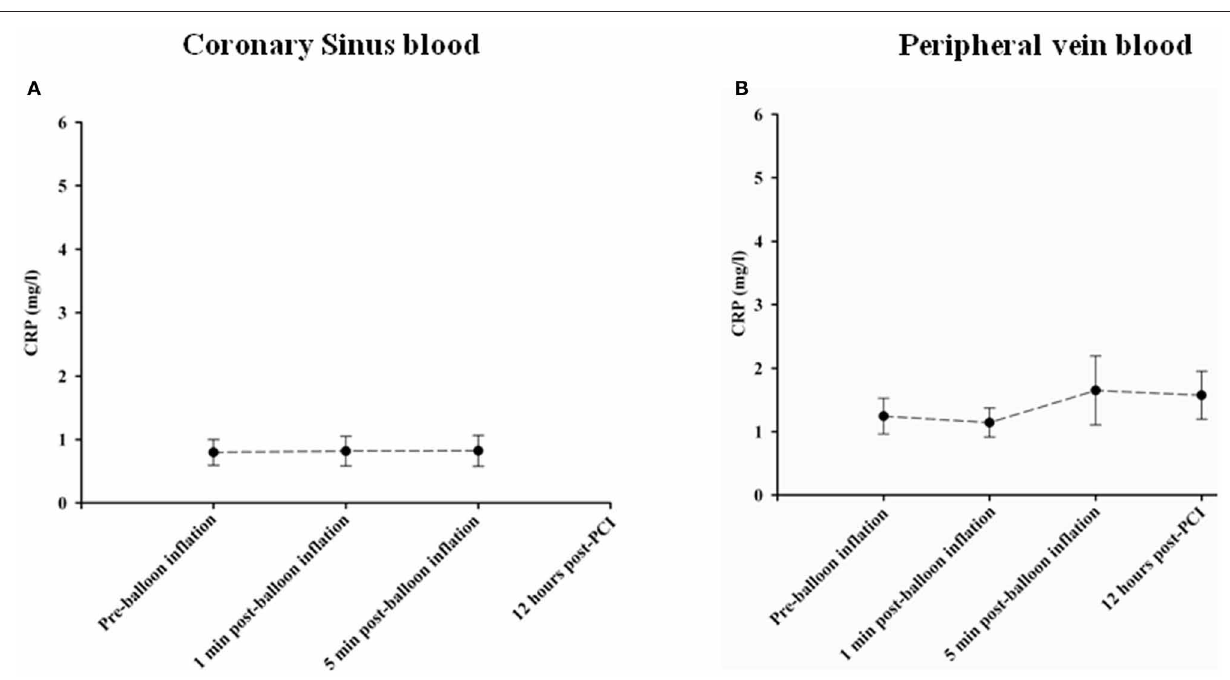
MI may be due to the more prolonged ischaemia during MI resulting in degradation of sphingosine kinase 1 (Maceyka et al., 2007) and an inhibition of its activity mediated by ROS leading to decreased levels of S1P and its metabolites (Knapp et al., 2009).